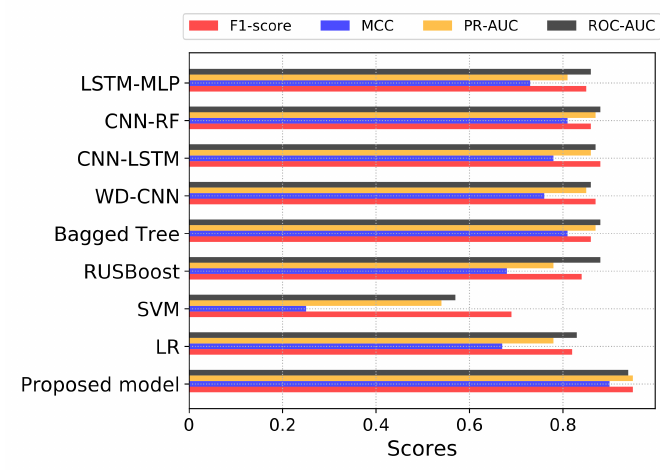
Figure 11. Proposed model’s ROC-AUC-based analysis without using IQMOT.